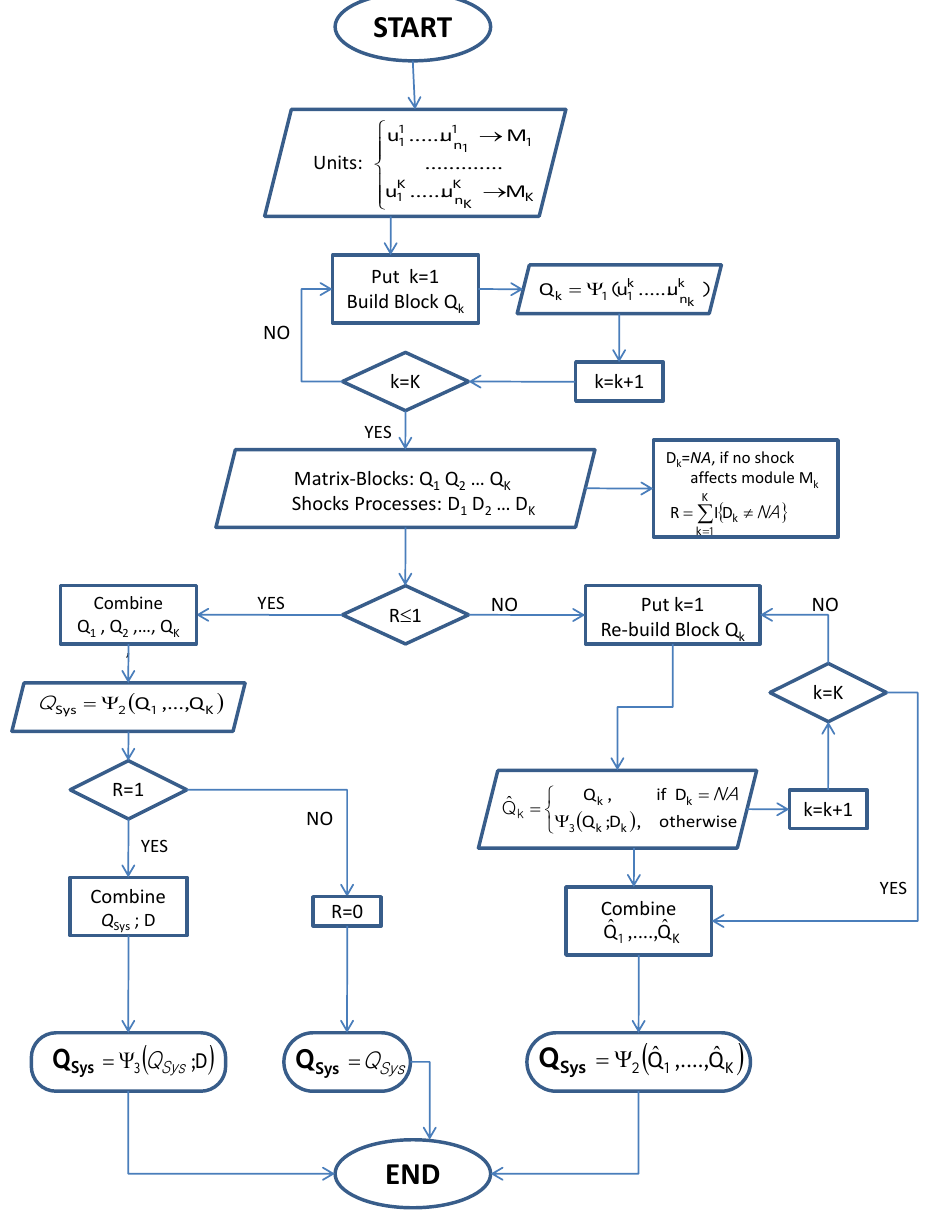
Figure 1. MoMA: Modular Matrix-Analytic